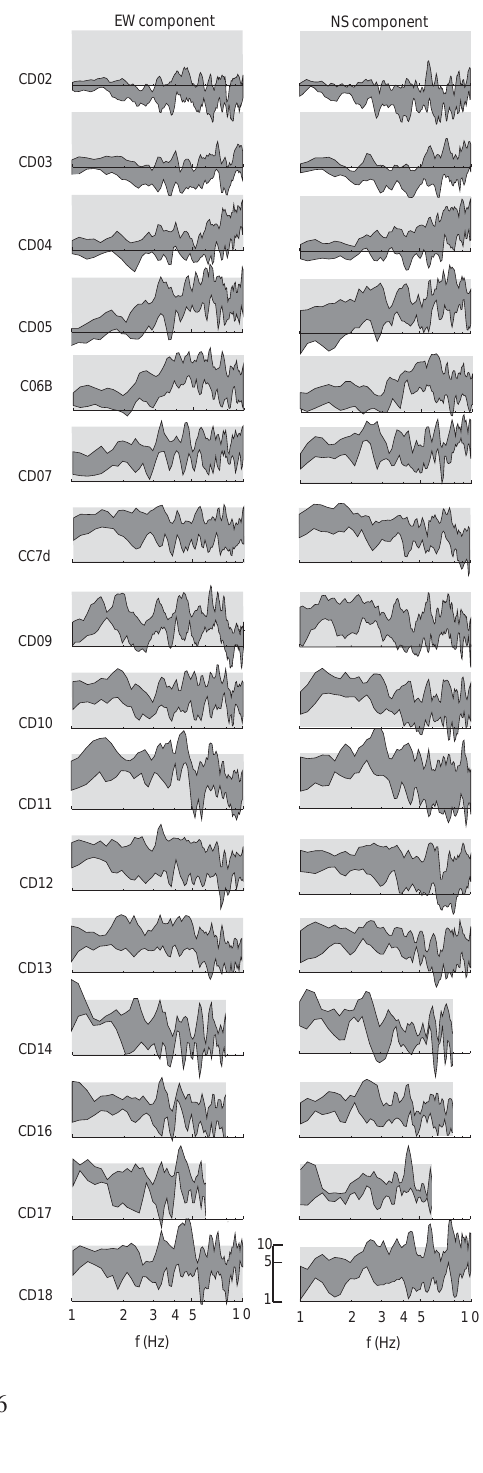
Fig. 7 . Standard deviation about the geometric mean amplification of the NS and EW components. Stations across the valley are ordered from east, above, to west,